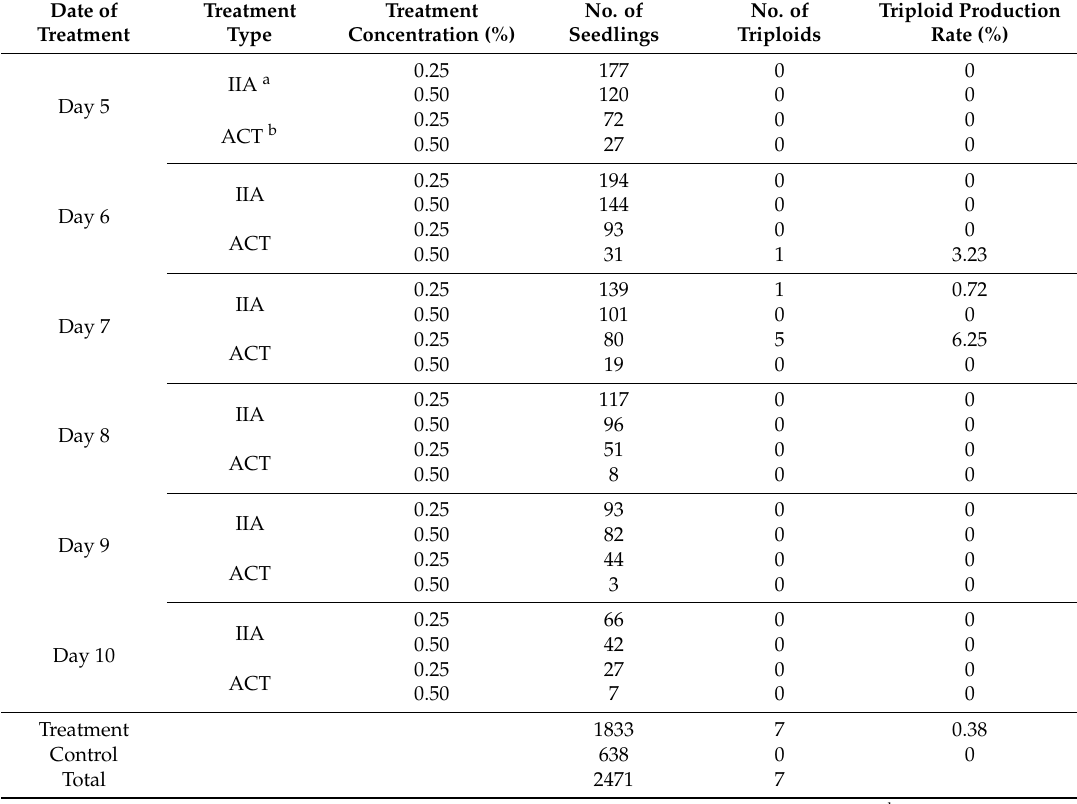
Table 3. Triploid production via megaspore chromosome doubling by colchicine treatment in Eucalyptus urophylla .